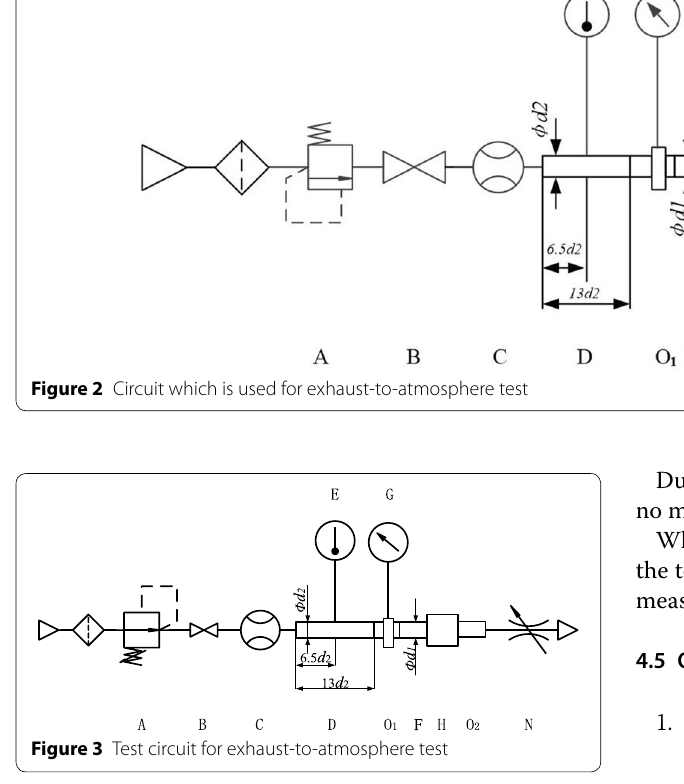
Table 3 Keys of testing the circuit components